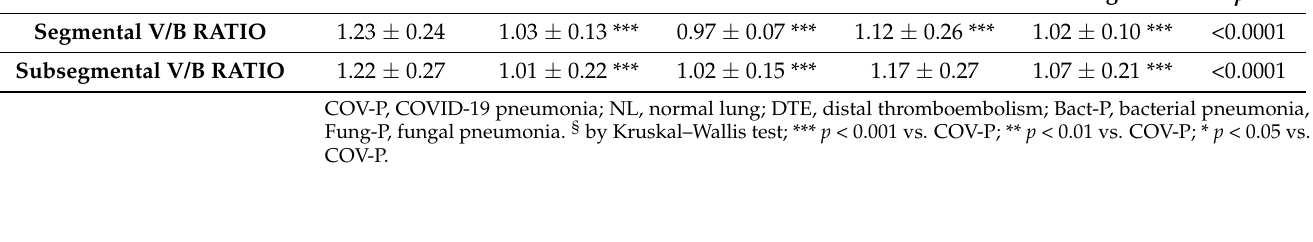
Table 1. Ratio between the caliber of the segmental and subsegmental branches of the pulmonary arteries and their corresponding bronchial branches, measured on healthy lung parenchyma. COV-P NL DTE Bact-P Fung-P p § Segmental V/B RATIO Subsegmental V/B RATIO COV-P, COVID-19 pneumonia; NL, normal lung; DTE, distal thromboembolism; Bact-P, bacterial pneumonia, Fung-P, fungal pneumonia. § by Kruskal–Wallis test; *** p < 0.001 vs. COV-P; ** p < 0.01 vs. COV-P; * p < 0.05